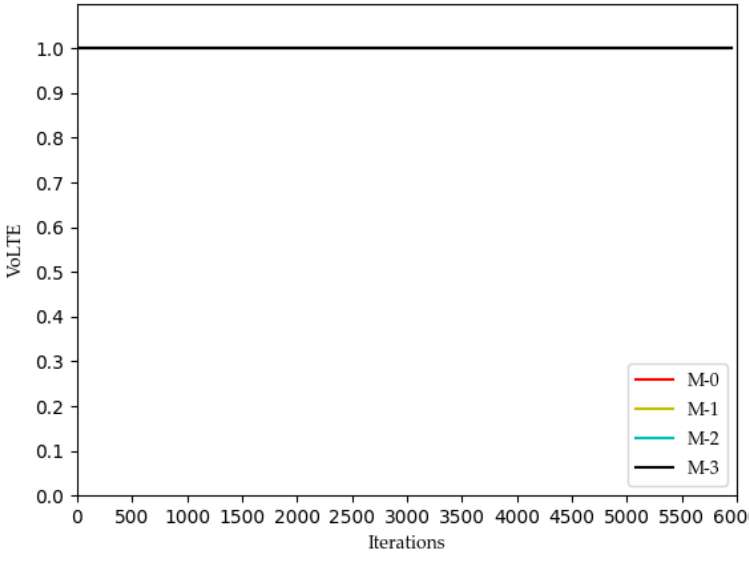
Figure 2. Optimization curve of QoE of VoLTE for each MVNO in the lower model based on DQN.